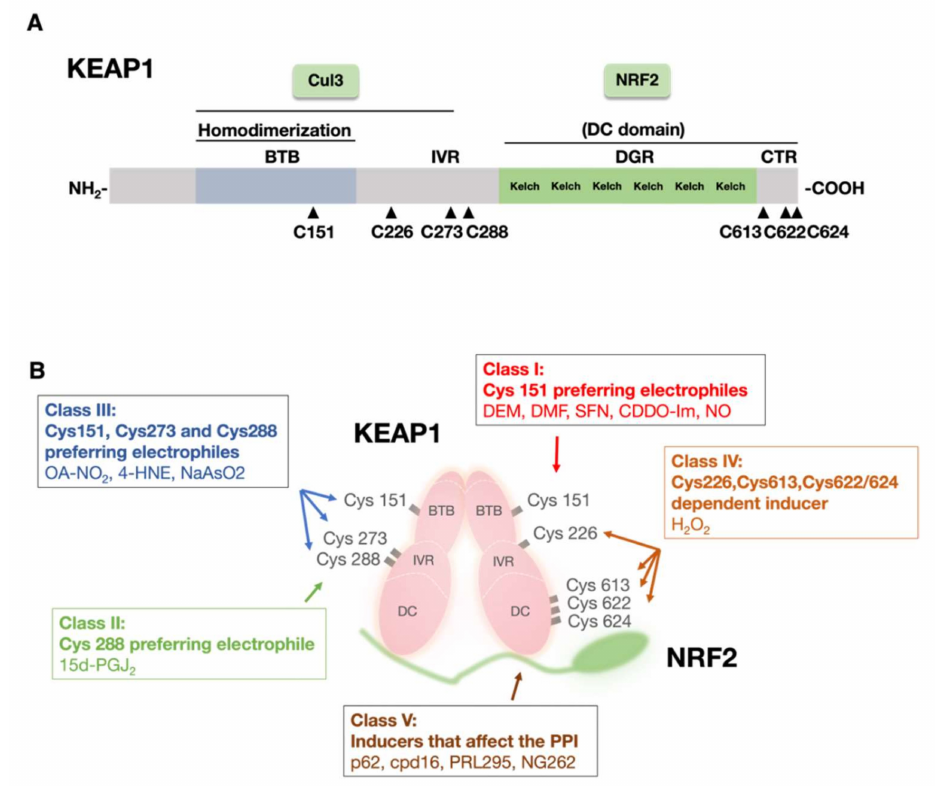
Figure 2. ( A ) Domain structure and function of KEAP1. KEAP1 comprises three main domains: the Bric-a-Bric (BTB) domain, intervening region (IVR), and double glycine repeat (DGR) region. The BTB domain is critical for KEAP1 homodimerization. The DC domain consists of the DGR and carboxyl-terminal region (CTR) and is important for the binding of KEAP1 to NRF2. ( B ) KEAP1 is a sensor for electrophiles and reactive oxygen species (ROS) . NRF2 inducers can be divided into four categories based on their preference for Cys151, Cys273, Cys288 or the Cys226, Cys613, or Cys622/624 residues in KEAP1. The fifth class of NRF2 is independent of these cysteines and activates NRF2 by inhibiting the protein–protein interaction (PPI) of KEAP1 with